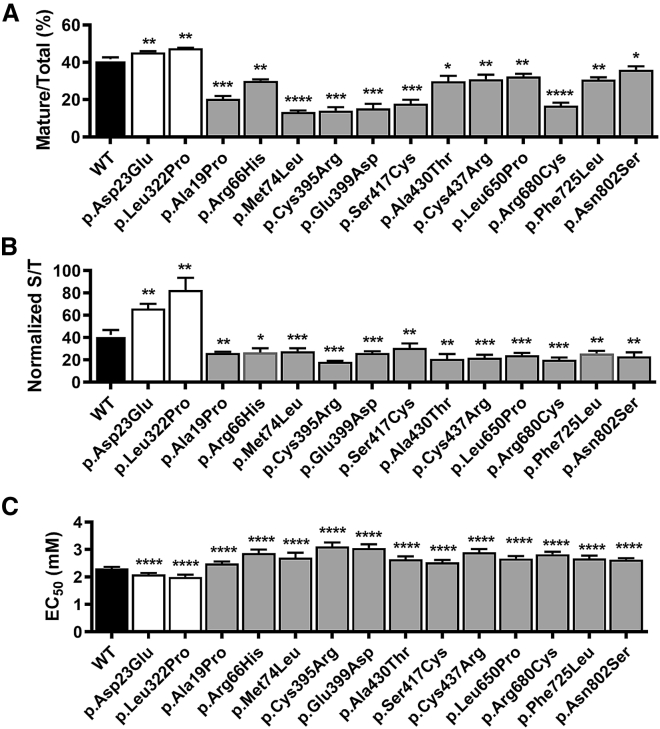
Biochemical and Cellular Analysis of mLoF and mGoF CaSR Mutations(A) Plot presents mean ± SD of western blot analysis of lysates from three independent HEK293 cell transfections, as the percent of mature receptors ([mature/(immature + mature)]%) for WT (black bar), mGoF (white bars), and mLoF (gray bars) variants. Representative western blots presented in Figure S3. Statistical analysis was by Student’s t test, with ∗p < 0.05, ∗∗p < 0.01, ∗∗∗p < 0.001, and ∗∗∗∗p < 0.0001.(B) Plasma membrane localization was determined for WT (black bar), mGoF (white bars), and mLoF (gray bars) variants by ELISA of transiently transfected HEK293 cells, plotted as the mean ± SD of the percent of surface to total expression, for at least three independent experiments. Statistical analysis was by Student’s t test, with ∗p < 0.05, ∗∗p < 0.01, ∗∗∗p < 0.001, and ∗∗∗∗p < 0.0001.(C) Bar graph of EC50 values for WT (black bar), mGoF (white bars), and mLoF (gray bars) variants extracted from fits of dose-response relations for Ca2+e. Statistical analysis by F-test, with ∗∗∗∗p < 0.0001. Titrations were done as described in Subjects and Methods, and plots of dose-response relations which were fitted to extract EC50s are presented in Figures S5 and S6. Numbering of residues for all graphs based on GenBank: NM_000388.4.